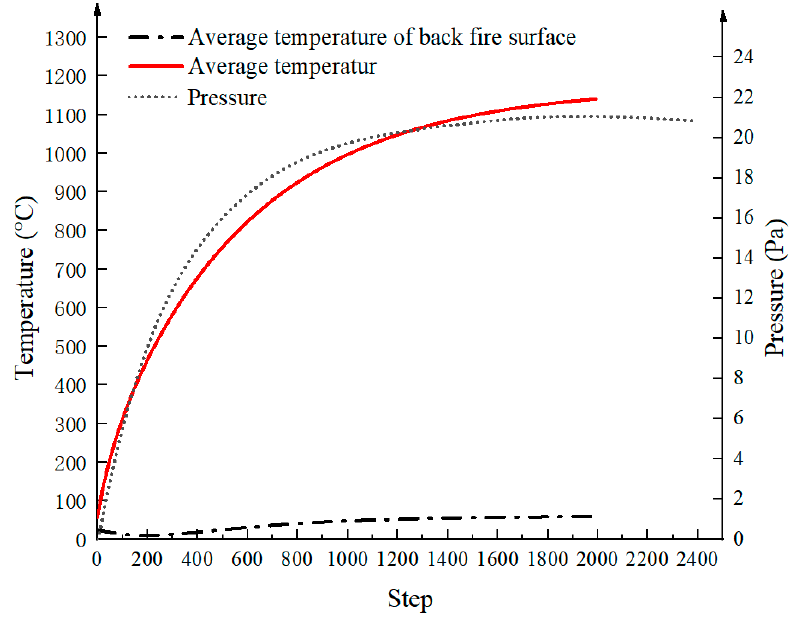
Figure 13. The curve of the fire resistance test.